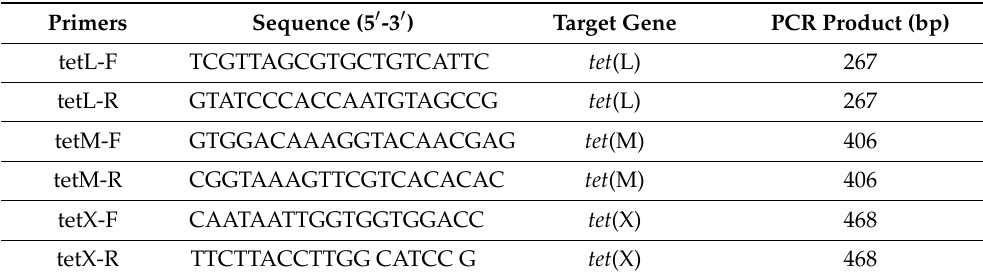
Table 2. Primers used for the detection of tetracycline resistance target